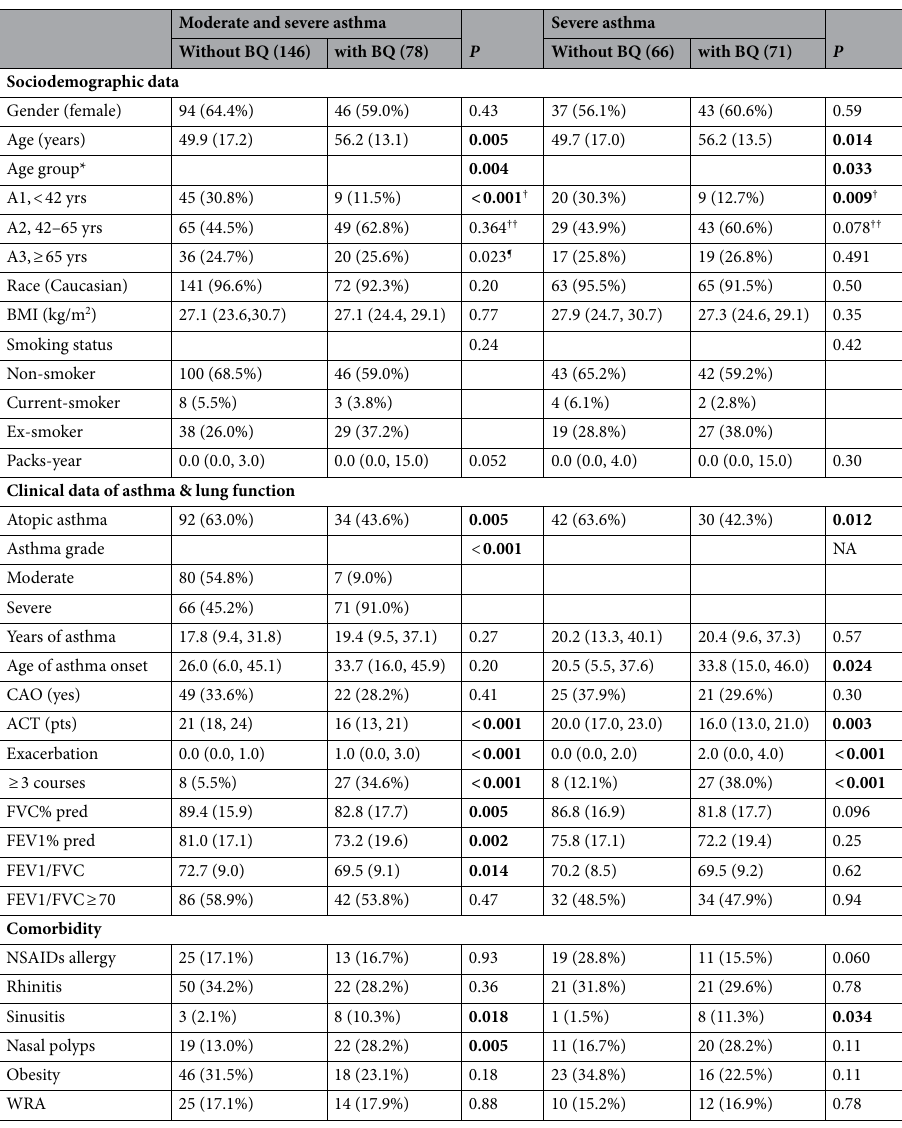
Table 1. Socio-demographic characteristics and clinical data of the study population. Continuous variables expressed as mean (SD) or median (p25, p75); categorical data expressed as percentage n (%); *Bonferroni adjust method was used to perform comparison between age subgroup, significant p level at 0.017; †, A1 vs A2; ††, A2 vs A3; ¶, A1 vs A3). BMI: body mass index; CAO: childhood asthma onset (18 yrs cut-off); ACT: asthma control test; BQ: non-cystic fibrosis bronchiectasis; WRA, work-related asthma. Significant p values in bold